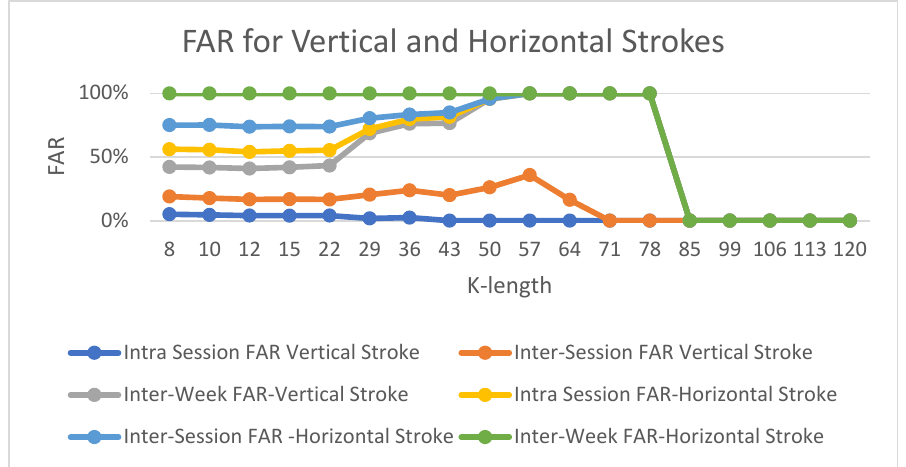
Figure 6. The results of FAR for the Touchalytics dataset with respect to k-length with the third experiment.